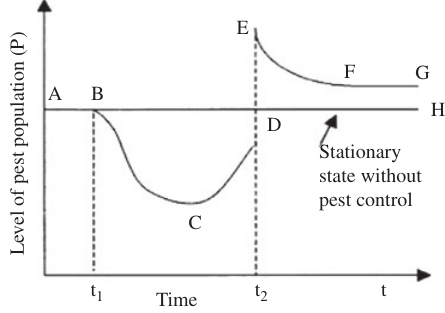
Figure 2 Level of pest population (Wilson and Tisdell 2001).